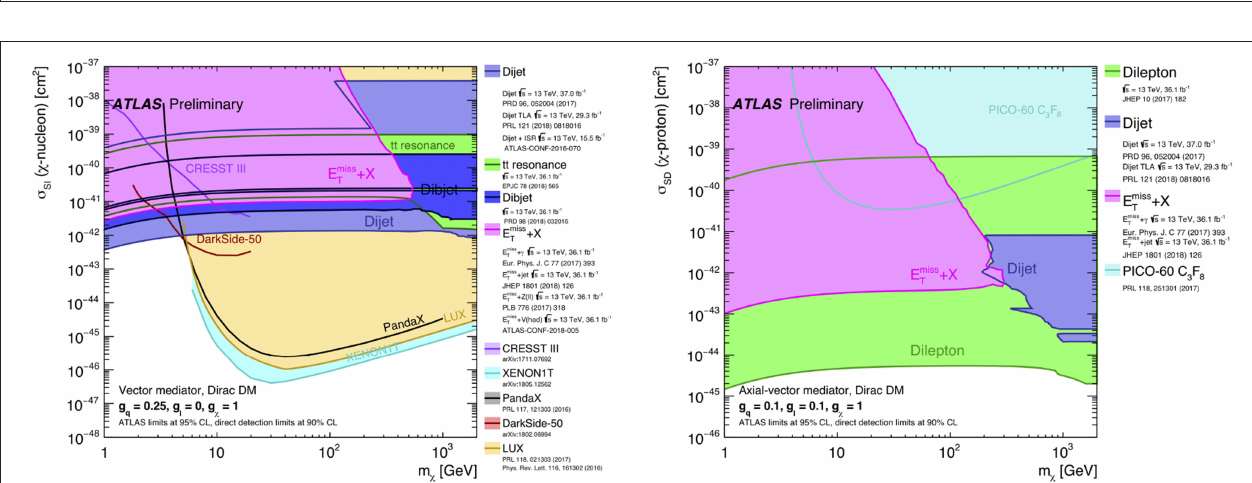
FIGURE 4 | Exclusion limits for color-neutral scalar (Left) or pseudo-scalar (Right) mediator models as a function of the mediator mass for a DM mass of 1 GeV. The limits are calculated at 95% CL and are expressed in terms of the ratio of the excluded cross-section to the nominal cross-section for a coupling assumption of g q g χ 1. The solid (dashed) lines show the observed (expected) exclusion limits for each channel. = =